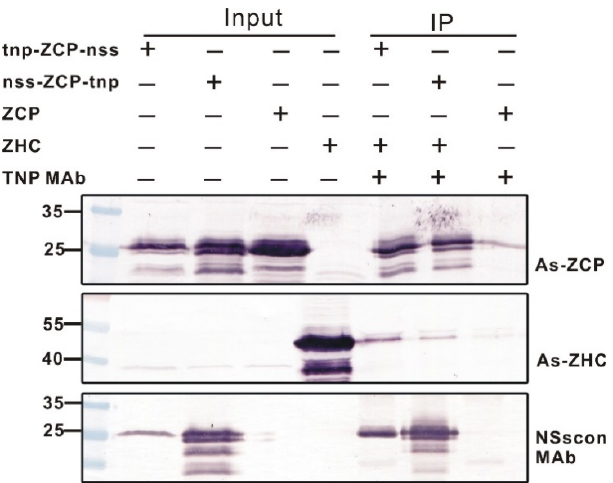
Figure 6. Co-immunoprecipitation of the np-tagged zucchini yellow mosaic virus (ZYMV) coat protein (ZCP) using TNP MAb 20C4C8 in vitro. The recombinant ZYMV CP and HC-Pro were expressed in np-tagged and untagged form, respectively, by the bacterial expression system. “Input” indicates that the solution contained only the np-tagged CP (ZCP) or the non-tagged HC-Pro (ZHC). “IP” indicates that the TNP MAb was used to pull down the np-tagged CP from the CP/HC-Pro mixed solutions. The presence of np-tagged CP or untagged HC-Pro from the “Input” and “IP” fractions was detected by western blotting using ZYMV CP antiserum (As-ZCP) [39], HC-Pro antiserum (As-ZHC) [43] and NSscon MAb [37], separately.